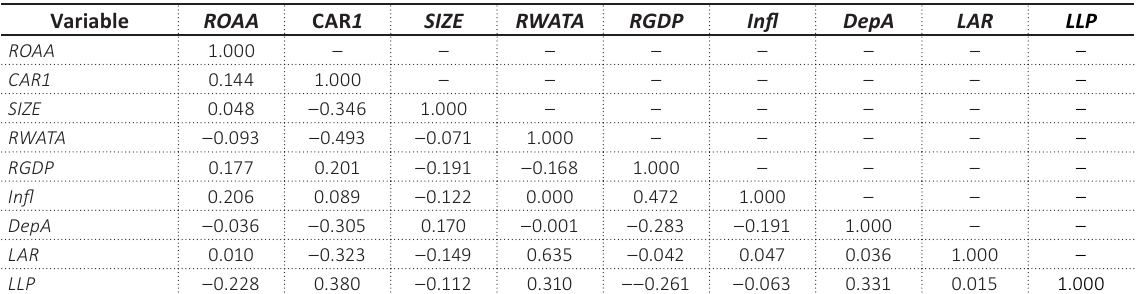
Table 3. Correlation coefficient